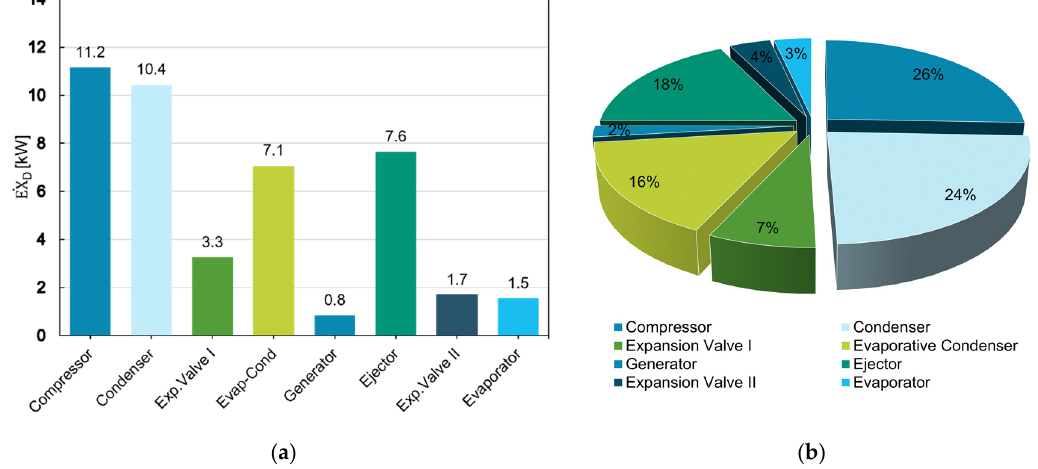
Figure 6. Exergy destruction ( a ) for system component and ( b ) component percentage exergy destruction. Figure 6b quantifies in detail the percentage of exergy destruction, compressor,